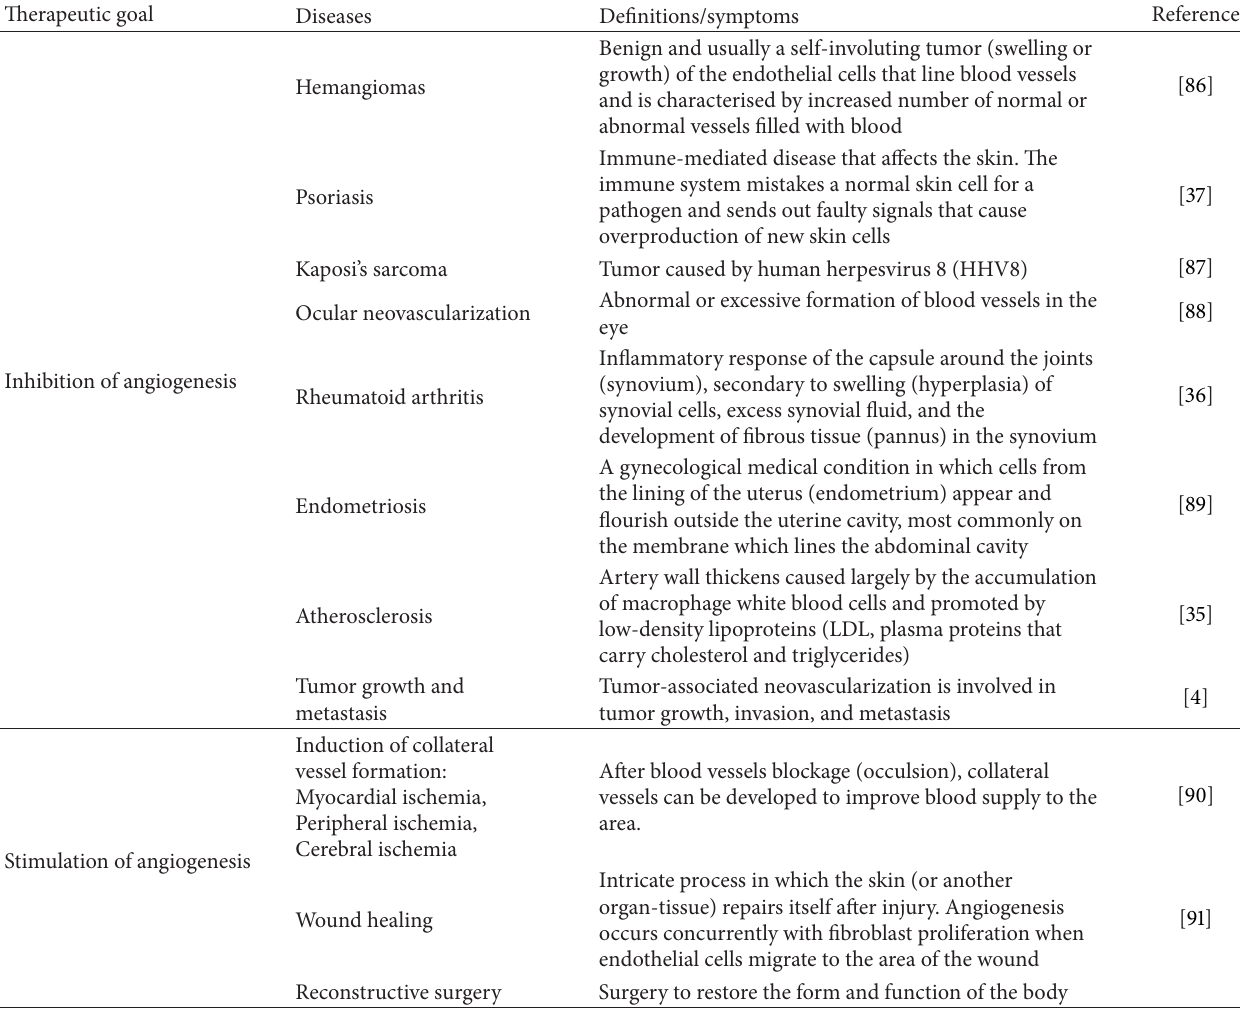
Table 2: Clinical manipulation of